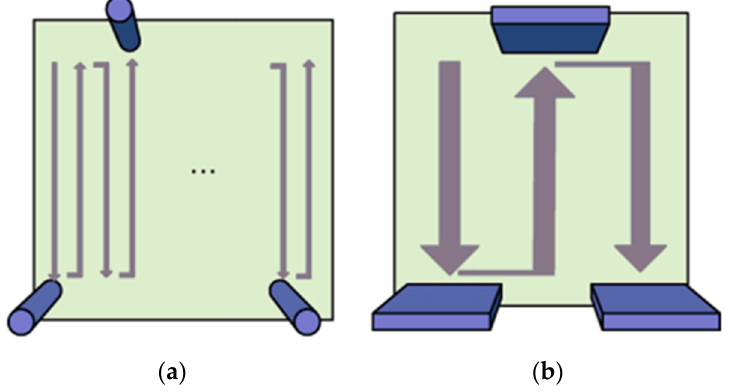
Figure 10. Comparison between conventional C-scan and phased array C-scan: ( a ) conventional ultrasound probe scanning path; ( b ) phased array ultrasonic probe scanning path with permission from [76], 2017, Journal of Mechanical Engineering.